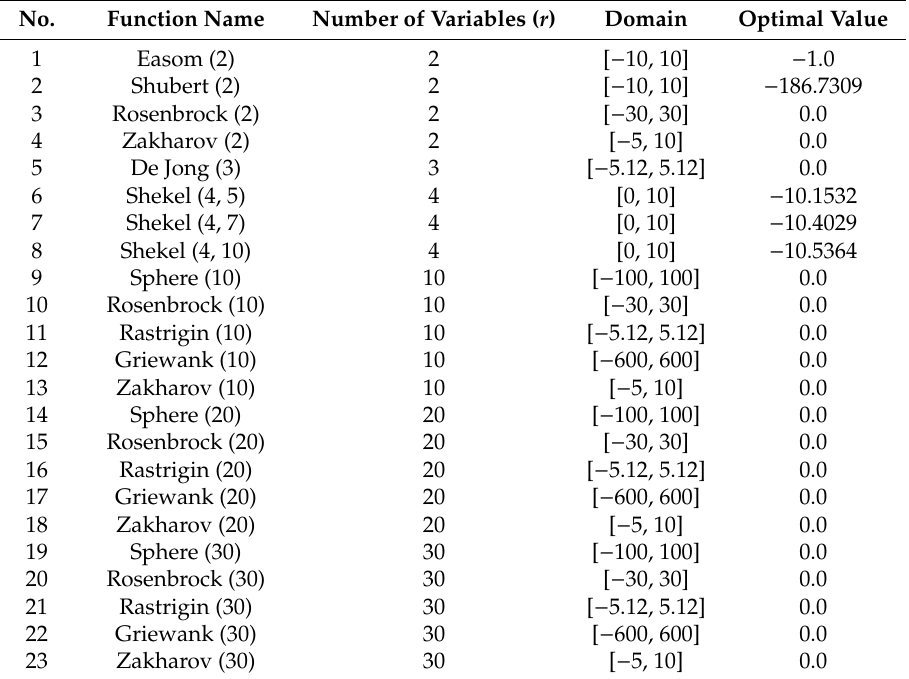
Table 1. The number of variables, domain, and optimal value of the benchmark functions.